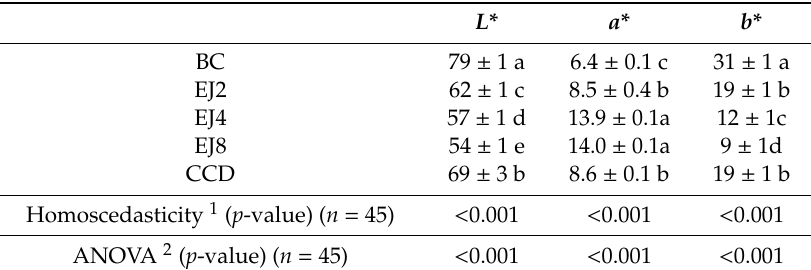
Table 4. Colour parameters ( L *, a * e b *) of di ff erent croissant